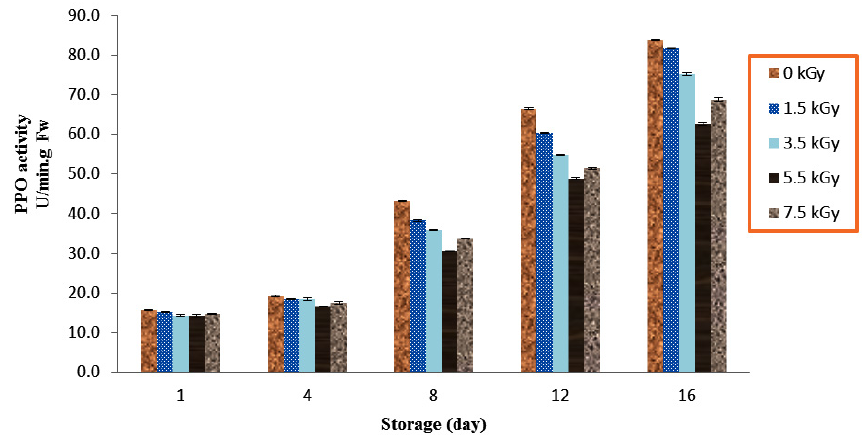
Fig. 4. Effect of Electron-Beam Irradiation on PPO Activity Using Pyrogallol as Substrate in Agaricus Brunnescens Fruit Bodies During Storage at 4 °C. Vertical Bars Represent the Standard Deviation about the Mean (r =